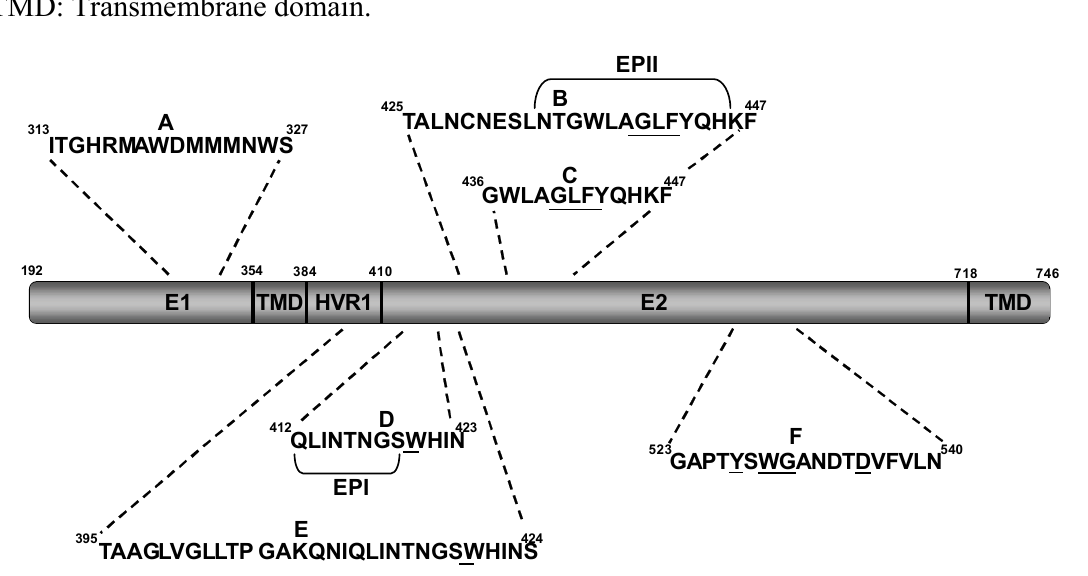
Figure 2. Conserved epitopes recognized by broadly nAbs in E1 and E2. Underlined letters indicate residues critical for E2-CD81 binding. HVR1: Hypervariable region 1; TMD: Transmembrane domain.